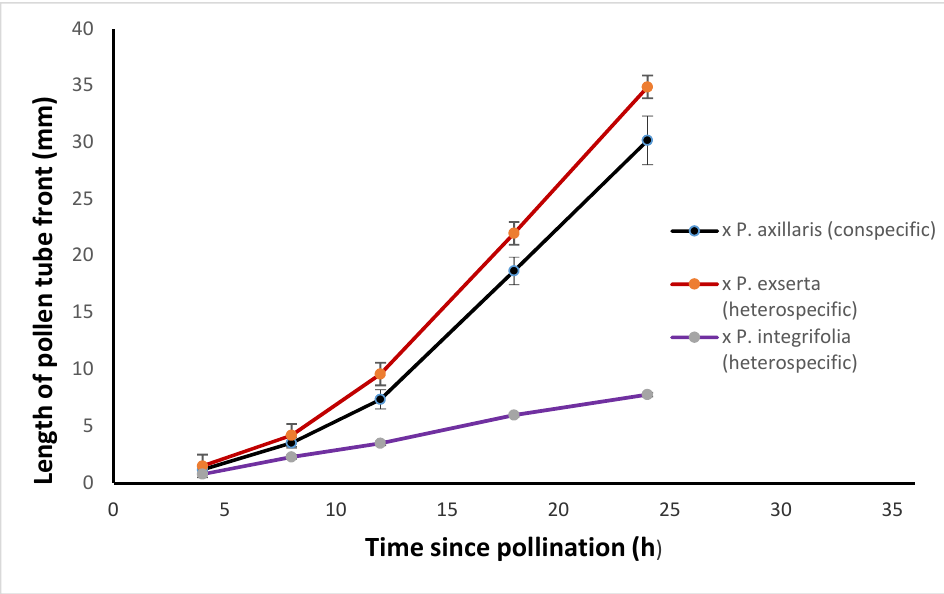
Figure 4. Time course of pollen tube growth in P. axillaris axillaris pistils following cross-pollination with conspecific pollen, and two types of heterospecific pollen (from P. exserta or P. integrifolia ). Error bars show standard deviation of measurements from six pollinated pistils. The pollen tube front is defined as the length of the longest bundle of pollen tubes that contains 20 or more pollen tubes.